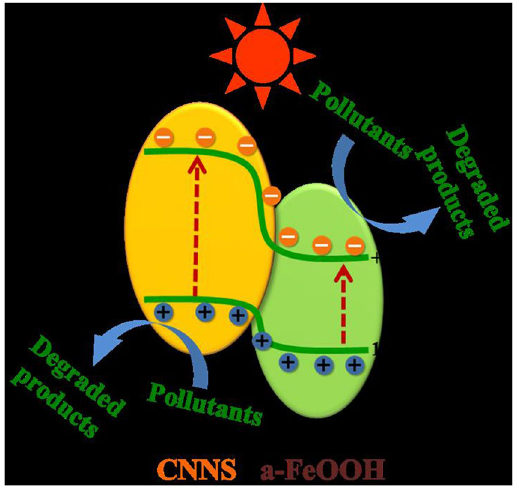
Figure 12. Proposed mechanisms of photo-generated charge transfer and pollutants degradation in the a-FeOOH/CNNS composites under visible light